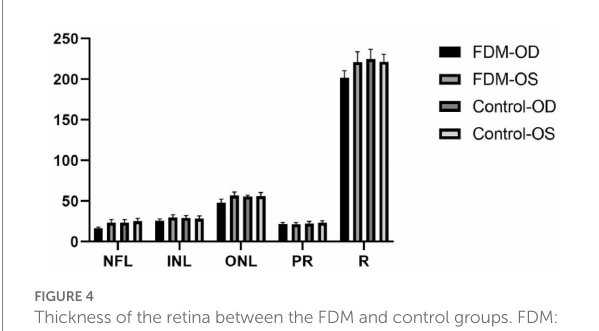
FIGURE 4 Thickness of the retina between the FDM and control groups. FDM: form-deprivation myopia; OD: oculus dexter; OS: oculus sinister; R: retina; NFL: nerve fiber layer; INL: inner nuclear layer; ONL: outer nuclear layer; PR: